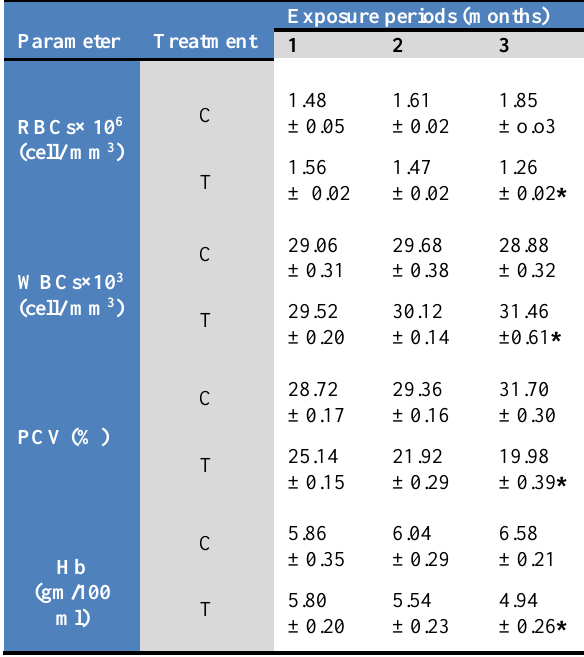
Table, 3: Changes in blood parameters of C. carpio exposed to contaminated feed with A. flavus .